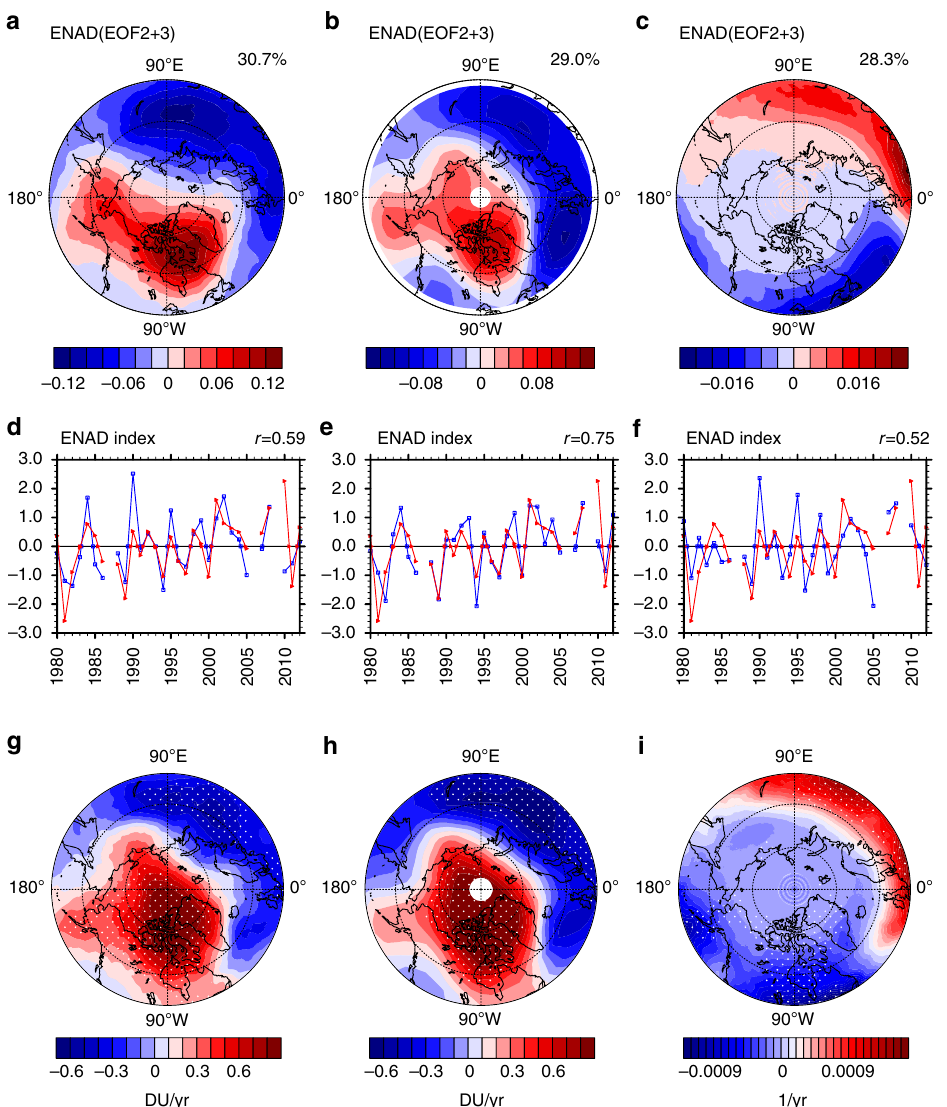
Fig. 2 Eurasia-North America dipole mode of total column ozone and clear-sky ultraviolet radiation. a – c Spatial patterns of Eurasia-North America dipole (ENAD) mode (EOF2 + EOF3) and d – f time series of normalized ENAD index (principal component (PC)2 + PC3) (blue lines) of February mean total column ozone (TCO) over 45 – 90°N derived from a , d MSR2 data and b , e SLIMCAT full chemistry simulation, and c , f February mean clear-sky ultraviolet radiation index derived from MSR2 data. Time series of vortex shift index (see Methods section, red lines) are overlaid in d – f . The percentage of explained variance is shown in the top right of a – c , and the correlation coef fi cients between PC2 + PC3 and the vortex shift index are shown in the top right of captions in d – f . Linear trends of g MSR2 TCO, h SLIMCAT TCO and i MSR2 UV index regressed on the vortex shift index are also shown. The linear trends over the dotted regions are statistically signi fi cant at the 90% con fi dence level according to the Student ’ s t test. The minimum latitude of polar stereographic projections is 45°N. The values in 1987, 2006 and 2009 are not included because the polar vortex broke up and its shape was distorted during February in these years